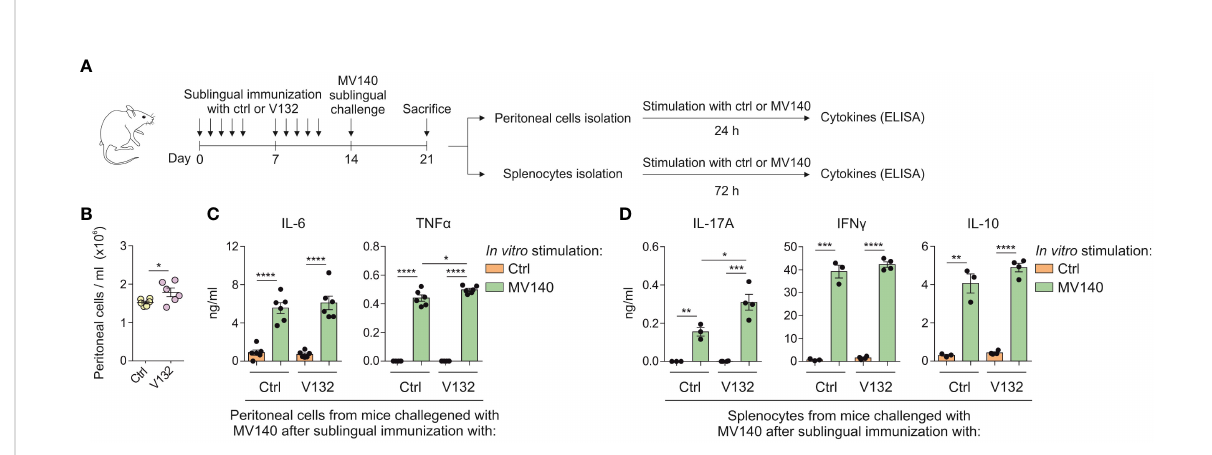
FIGURE 6 V132 induces trained immunity in mice and enhances adaptive immune responses against MV140. (A) Scheme of the sublingual immunization protocol and analysis of induced systemic response; ctrl; control excipients. (B) Concentration of peritoneal cells in the peritoneal cavity 7 days after stimulation with MV140 (n = 6 mice of one independent experiment). (C) Cytokine production by peritoneal cells from the indicated mice, stimulated in vitro with ctrl or MV140 for 24 h (n = 6 mice of one independent experiments). (D) Cytokine production by splenocytes from the indicated mice, stimulated in vitro with ctrl or MV140 for 72 h (n = 3-4 mice of one independent experiment). Values are mean ± SEM. Statistical signi fi cance was determined using Unpaired t test. *P < 0.05, **P < 0.01, ***P < 0.001, and ****P <